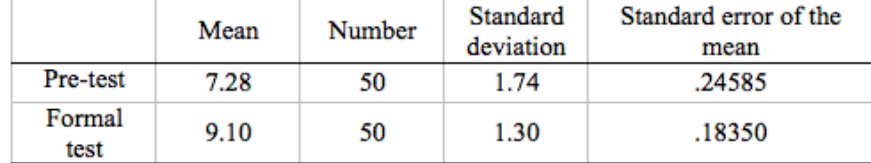
Distribution of number of questions with correct answers of students in the pre-test and formal test